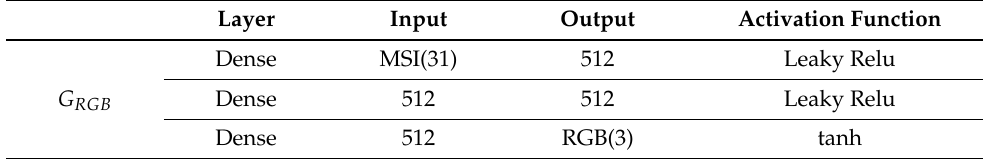
Table 3. The architecture of Generator G RGB